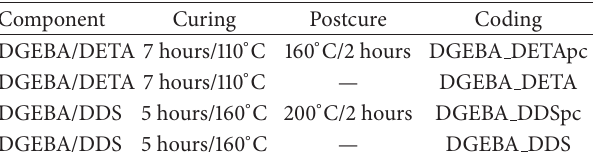
Table 1: Specification of the polymer matrix